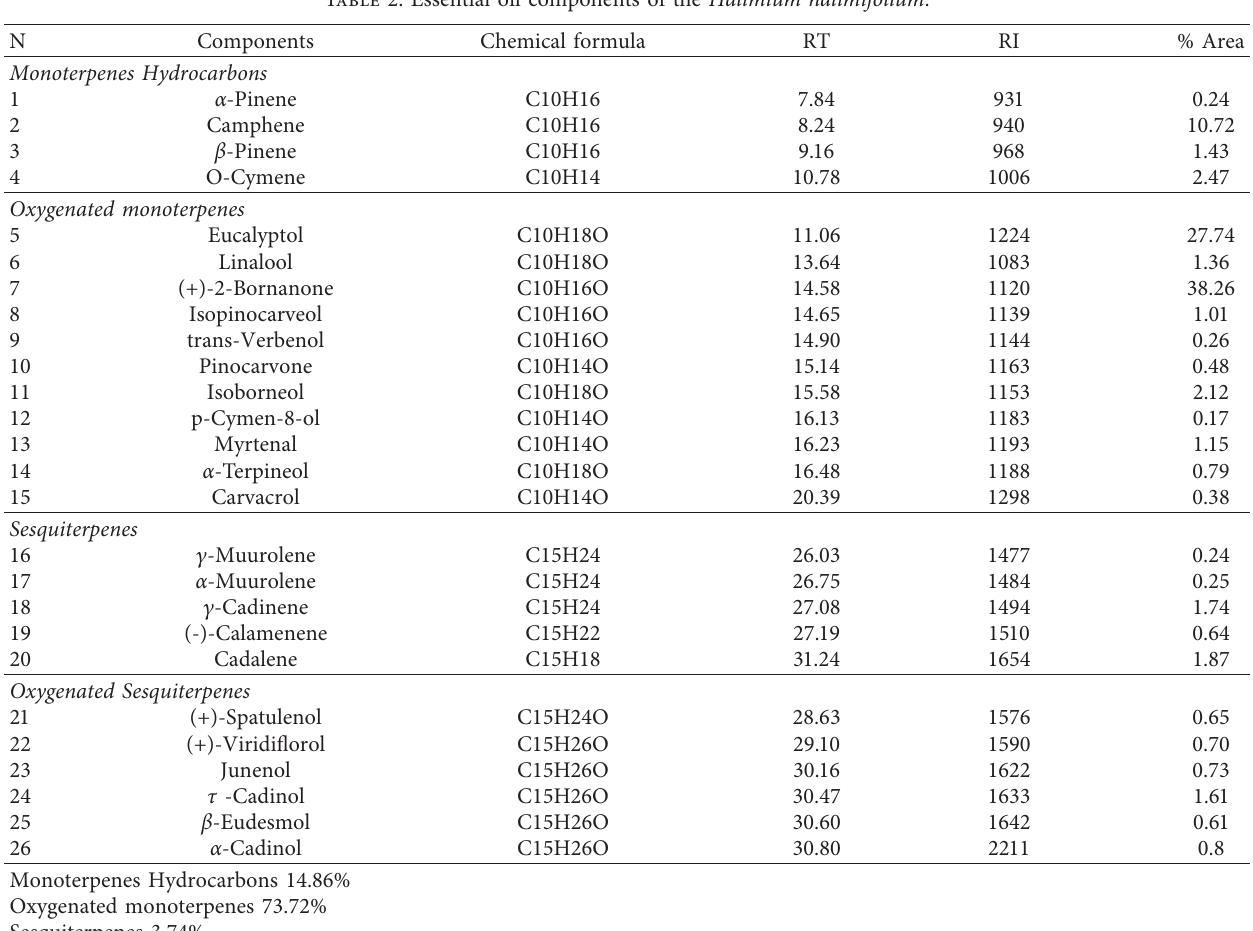
Table 2: Essential oil components of the Halimium halimifolium .